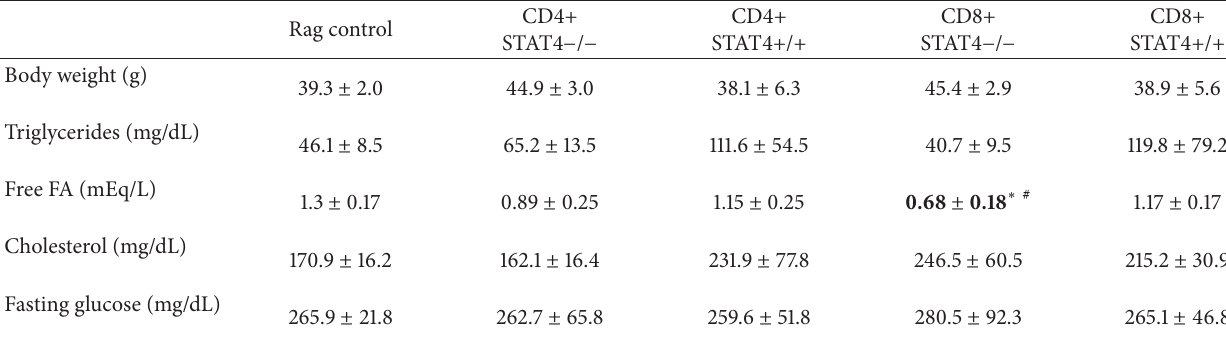
Results represent fasting body weights and plasma values at time of sacrifice. Data is from 𝑛 = 6–12 mice/group and represents mean ± SD. Statistical analysis was performed using one-way ANOVA and the null hypothesis was rejected for 𝑝 < 0.05 . ∗ Significant compared to Rag controls ( 𝑝 < 0.01 ). # Significant compared to CD8+STAT4+/+ mice ( 𝑝 < 0.05